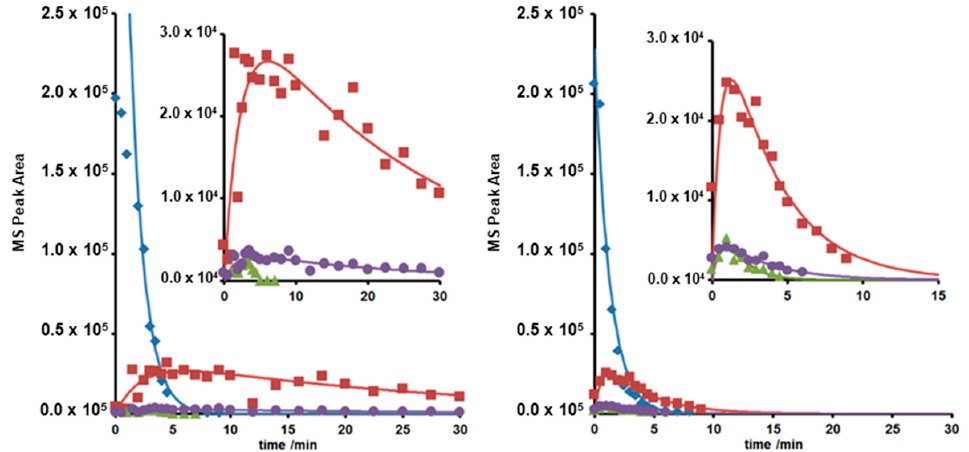
Figure 4. c-t curves of LOM ( ♦ ) and photodegradates with m/z = 308 ( ▲ ), 332 ( ■ ) and 350 ( ● ) under UVA (left) and UVC irradiation (right) at pH = 4–6 .